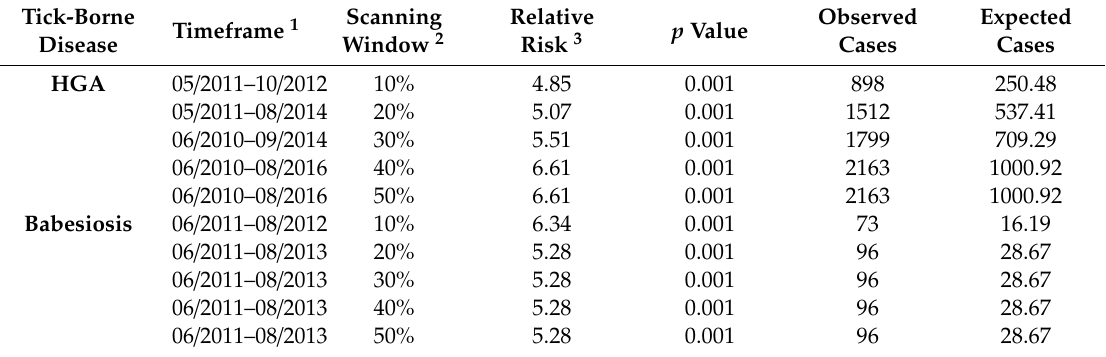
Table 3. Temporal clusters identified for laboratory positive cases of non-Lyme tick-borne diseases by disease type over varying time windows (10, 20, 30, 40 and 50%) with relative risks. Tick-Borne